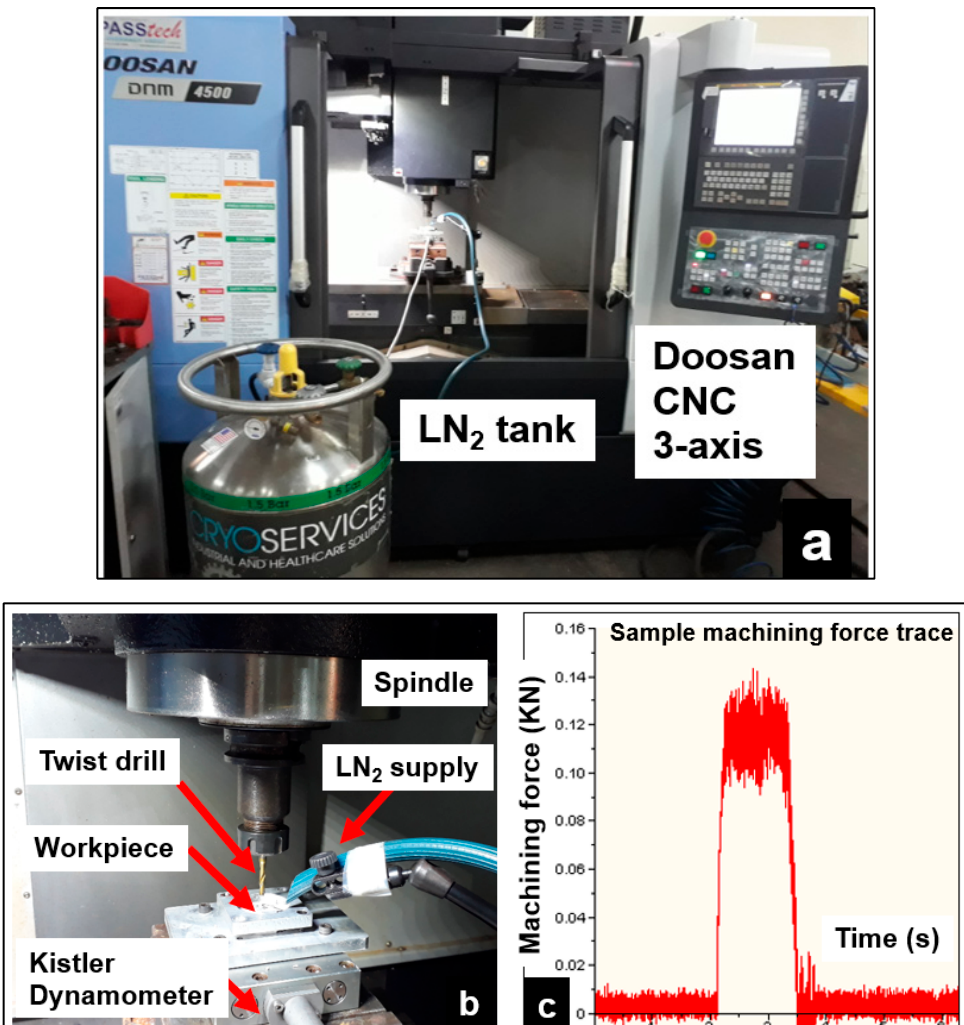
Figure 2. ( a ) Experiment set up; ( b ) Cutting force dynamometer; ( c ) Cutting force